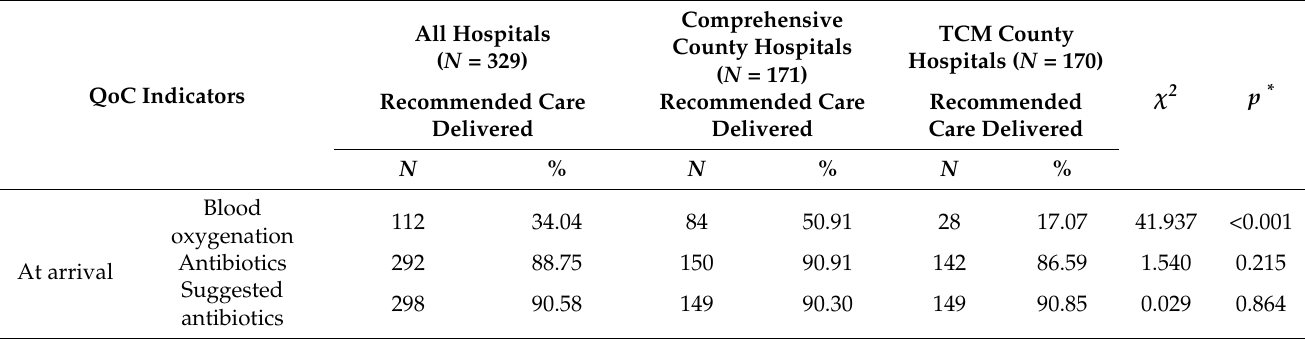
Table 6. Level of QoC for pneumonia in 2 kinds of county hospitals ( N =